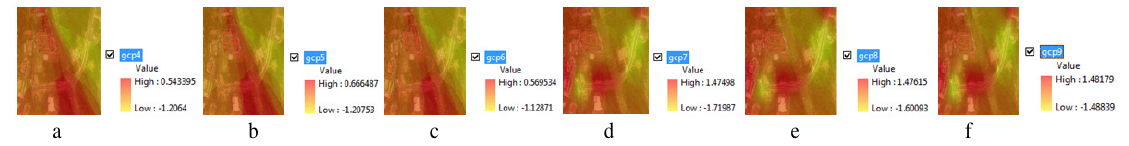
Figure 7. Error Interpolation based on Height Coordinates based on Different GCP